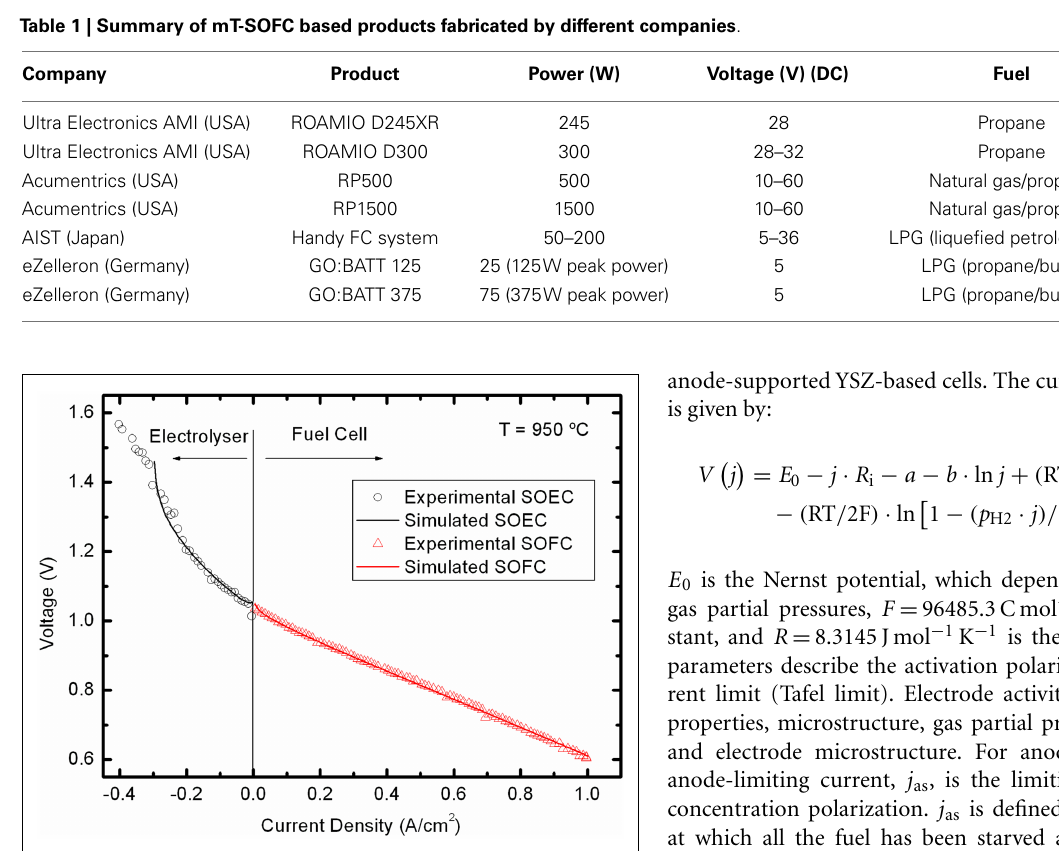
FIGURE 1 | Experimental j -V curves in both SOFC and SOEC modes of a Ni-YSZ/YSZ/LSM-YSZ mT-SOFC and their corresponding fitting using Eqs 1 and 2 . Operation conditions: 950°C using humidified pure hydrogen as fuel Laguna-Bercero et al.